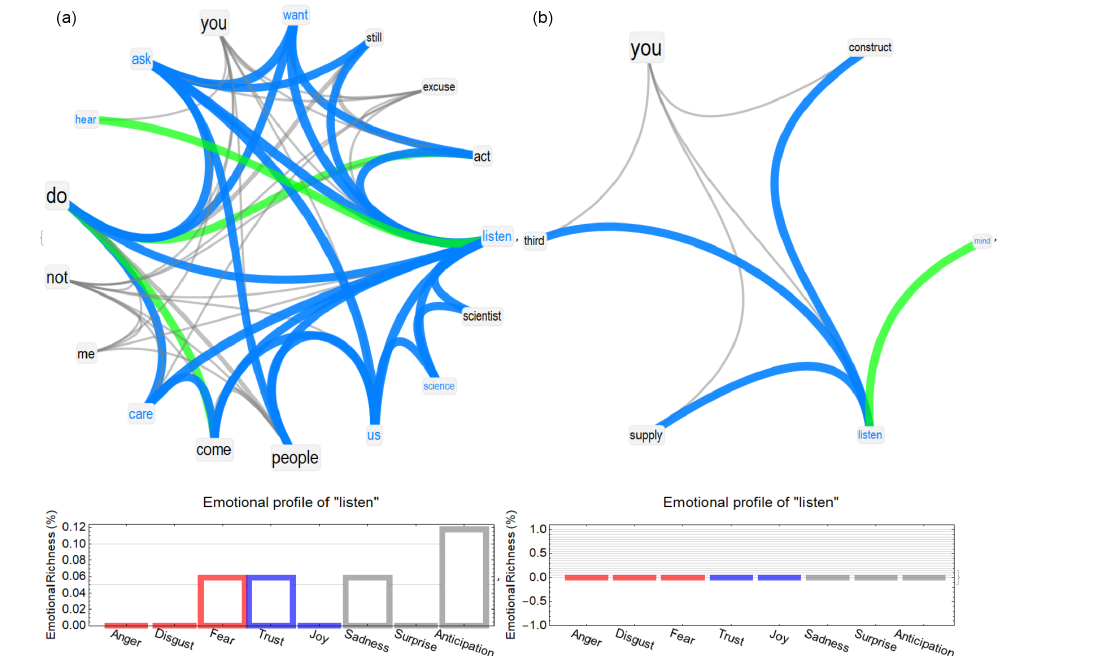
Figure A2. Speakers’ mindset reconstruction around “listen” in the speeches of Greta Thunberg (a) and Christopher Monckton (b) . We refer the reader to Fig. 1 for a detailed explanation of the colour code and to Lexicon 1 for an interpretation of the figure.